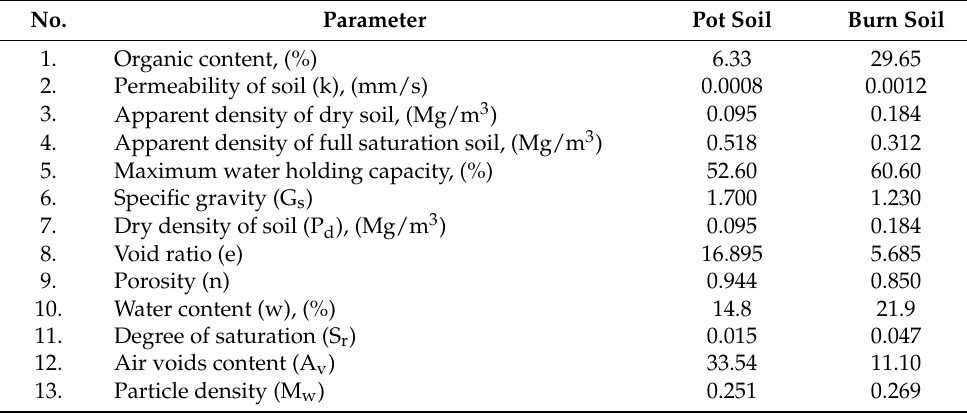
Table 1. Characteristics of pot and burn soils used in green roof